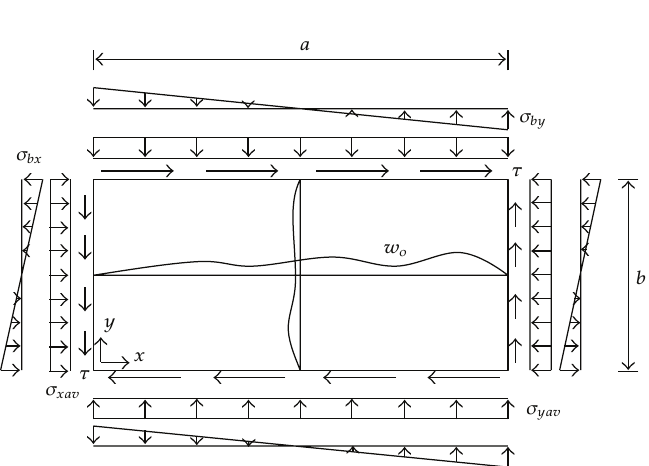
Figure 1: In-plane load components applied in a plate element.